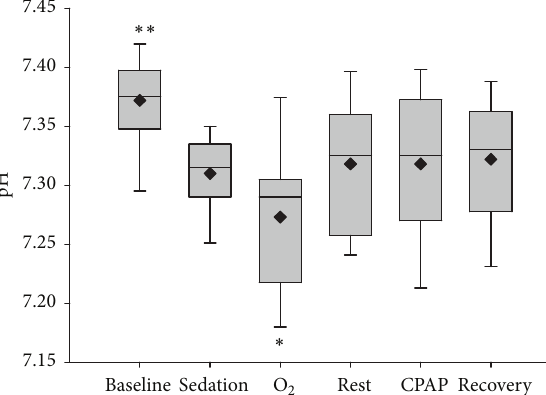
Figure 4: Arterial blood pH following sedation and respiratory sup- port by oxygen insufflation or continuous positive airway pressure (CPAP). Values are shown as median (horizontal line) and mean (diamond) and quartiles and range immediately after catheter place- ment (T0, baseline), 10 minutes following sedation (T1, sedation), following 10 minutes of oxygen supplementation (O 2 ), following 10 minutes of CPAP, and after 10 minutes of breathing ambient air following respiratory support (T3, rest, and T5, recovery). Order of respiratory support (O 2 supplementation or CPAP) was randomly assigned to replicate groups of paired calves and administered at T2 (5 calves) or T4 (5 calves); treatment order had no significant effect on response to O 2 supplementation or CPAP. Baseline results were significantly higher than results obtained at all other times ( ∗∗ 𝑃 < 0.001 ), and results obtained following O 2 supplementation were significantly lower than all other results ( ∗ 𝑃 < 0.005 ).